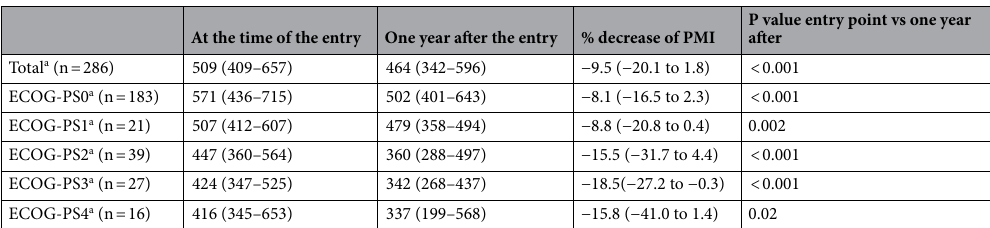
Table 2. Transition of the psoas muscle index by the performance status at the entry. Wilcoxon sum test was used for analysis. PMI psoas muscle mass index, ECOG-PS Eastern Cooperative Oncology Group performance status. a Median (interquartile